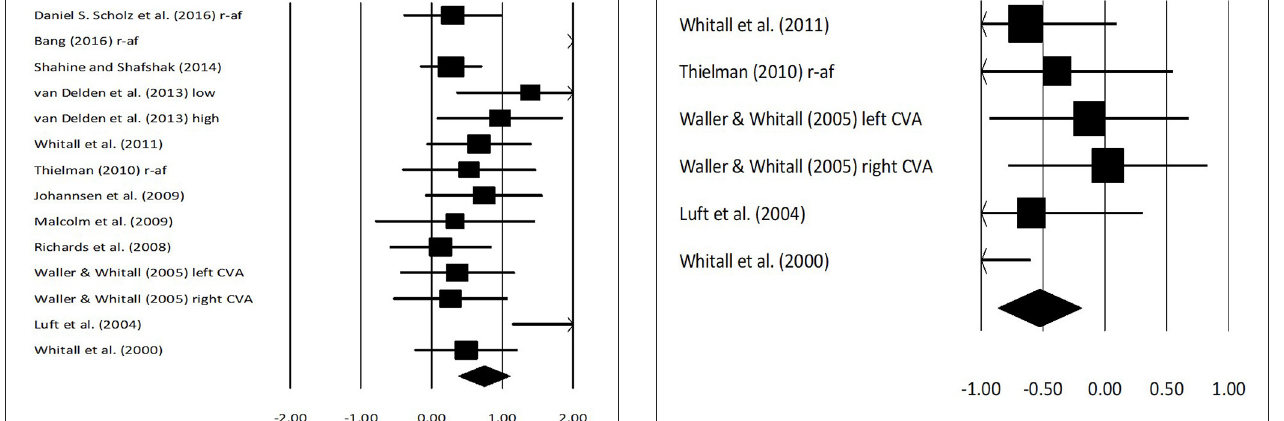
FIGURE 5 | Forest plot illustrating individual studies evaluating the effects of rhythmic auditory cueing, and real-time auditory feedback on Wolf motor time assessment scores for arm function amongst post stroke patients. Weighted effect sizes; Hedge’s g (boxes) and 95% C.I (whiskers) are presented, demonstrating repositioning errors for individual studies. The (Diamond) represents pooled effect sizes and 95% CI. A negative effect size indicated reduction in Wolf motor scores depicting a better arm functioning; a positive effect size indicated enhancement in Wolf motor scores depicting poor arm functioning. (r-af, Real-time auditory feedback; low, Low performance group; high, High performance group; left CVA, Left sided cerebrovascular accident; right CVA, Right sided cerebrovascular